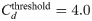
SAD results.Species abundance distribution (SAD) results for the generalists scenarios (A-C) and specialist scenarios (D-F). A: In the generalist scenario, the log-series distribution (black curve) fits the SAD when the coefficient of variation (CV) in the consumption matrix is sufficiently low (red points; Cramér-von Mises goodness-of-fit test p-value 0.78), but is rejected when the CV is sufficiently high (blue points; CvM test p-value 0.02). B: Probability that the logs-series distribution fits the SAD decreases with the CV of the consumption matrix. Points and error bars show the mean and standard error of the count of successful fits, out of an ensemble of 106 communities. Blue curve shows logistic regression. The threshold CV, defined as the point where the probability falls below 50%, is CVthreshold = 0.23. C: log(CVthreshold) has a linear relationship with log(n), with slope −0.61 ± 0.09. This indicates a power law between CVthreshold and n, with an exponent close to our analytic prediction of −0.5. Error bars show uncertainty propagated from the standard errors of the fitted parameters in the respective logistic regressions. Bands show the 95% CI of the linear regression. D: In the specialists scenario, communities with low Cd/Co ratio (red points; CvM test p-value 0.267) conform to the log-series distribution, while communities with sufficiently high Cd/Co (blue points; CvM test p-value <0.001) reject the LS distribution. E: The probability of the LS distribution fitting the SAD decreases as Cd/Co increases, with the threshold at Cdthreshold=4.0 (we set Co = 1). Each data point summarizes an ensemble of 143 communities. F: Cdthreshold increases linearly with the number of species in the community, in qualitative agreement with Eq 4. Parameters: A-B: K = S = 50, n = 500, r = 100. C: K = S = 50, r = 100. D-F: K = S = 50, n = r = 100.